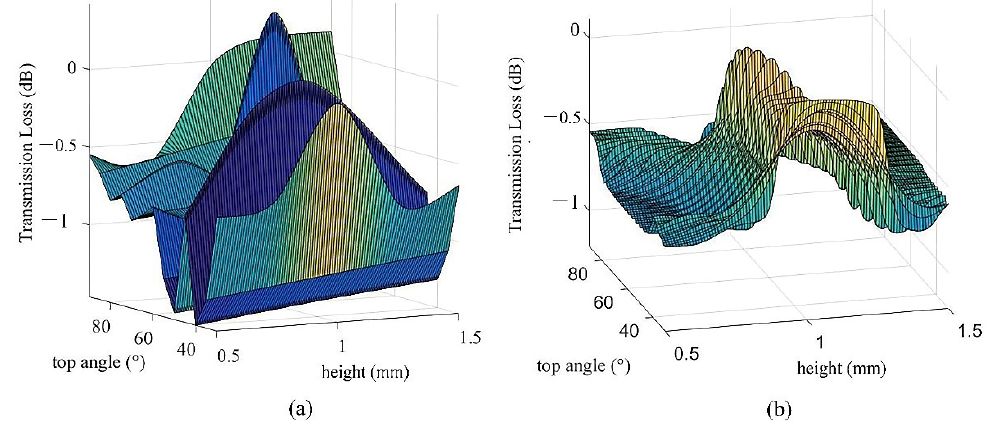
Figure 11. Relation between texture heights, top angles, and corresponding transmission loss ( a ) before optimization, ( b ) after optimization.